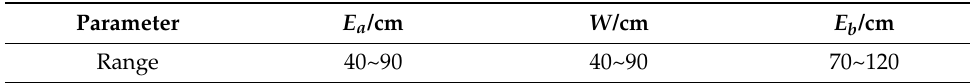
Table 6. Ranges of the parameters to be